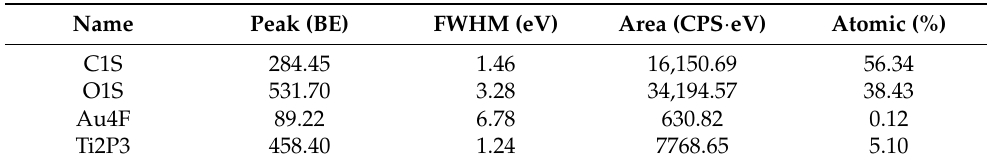
Table 2. Elements composition and quantitative evaluation of samples of treated shungite with gold nanoparticle.